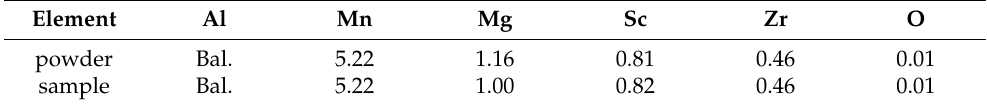
Figure 1. Powder analyze results: ( a ) powder morphology; ( b ) powder size distribution diagram. Table 1. Chemical element content of powder and samples for SLM (wt.%).